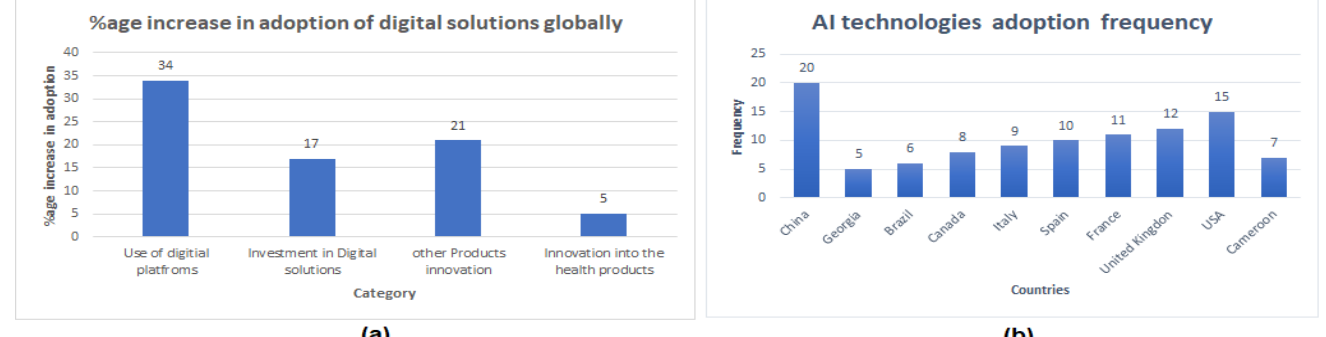
Figure 2. Statistics about ( a ) investment in digital solutions and ( b ) the adoption of AI around the